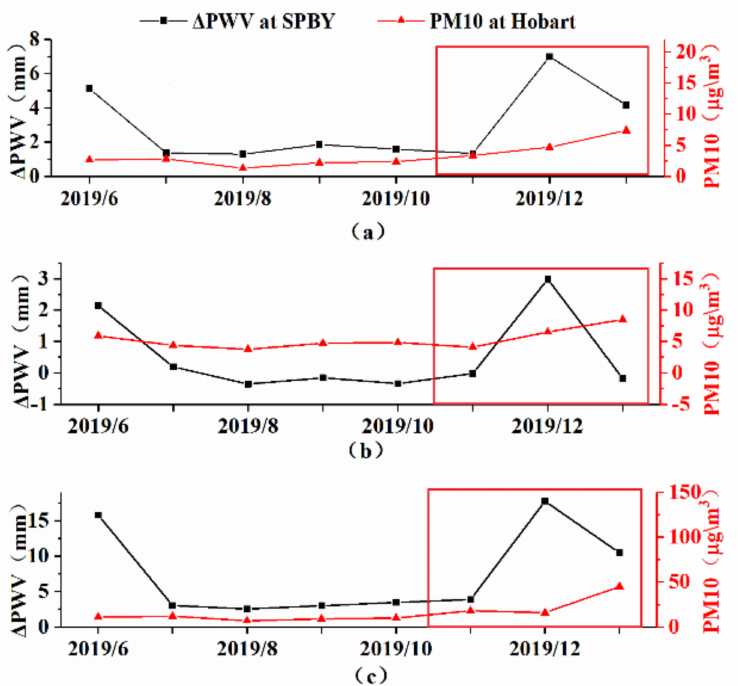
Figure 4. Statistical results of ∆ PWV and PM10 at SPBY (( a ) STD statistics, ( b ) MEAN statistics, ( c ) MAX statistics of